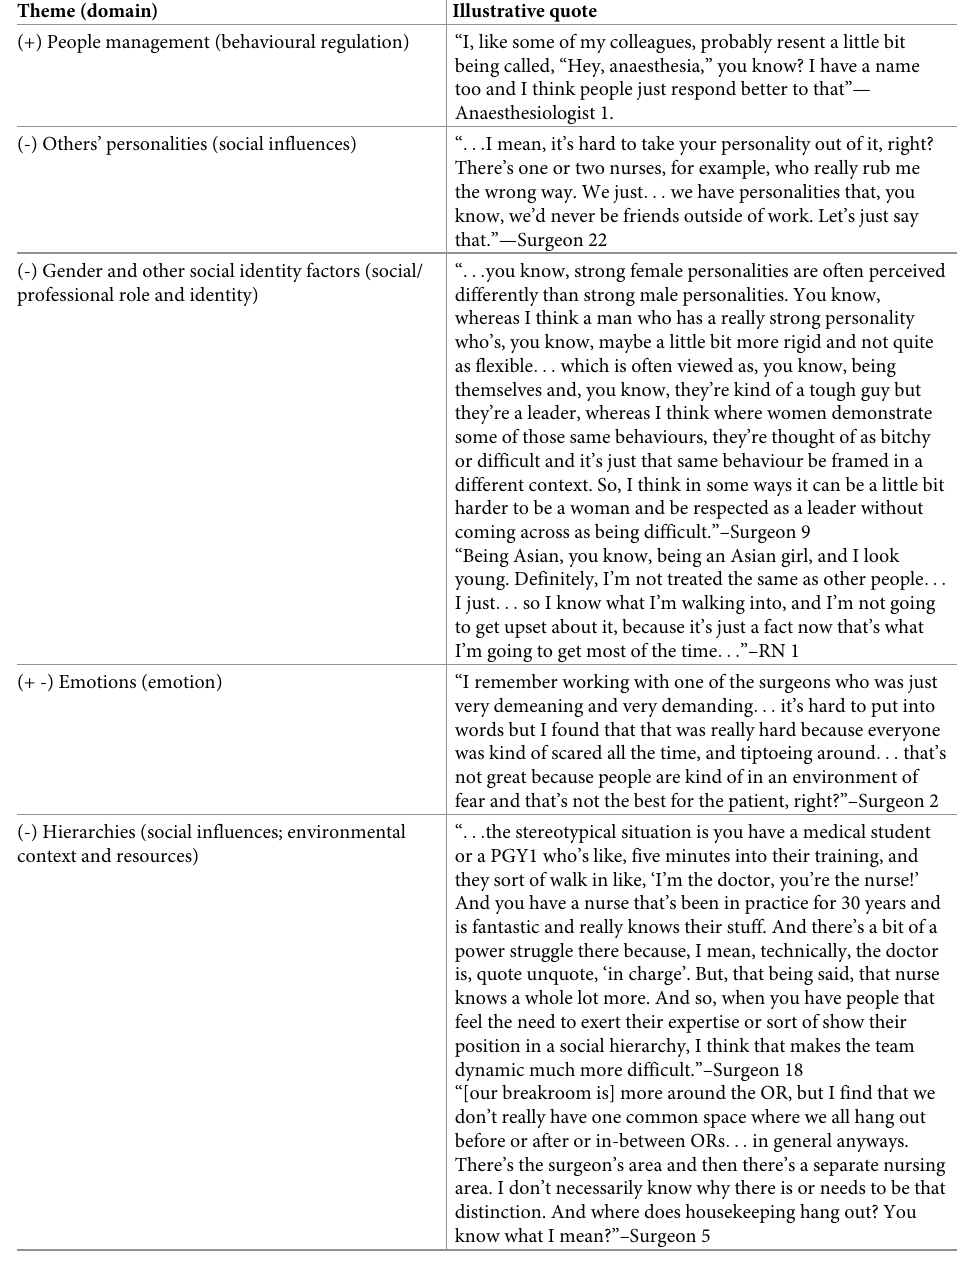
Table 3. Most commonly identified key themes and illustrative